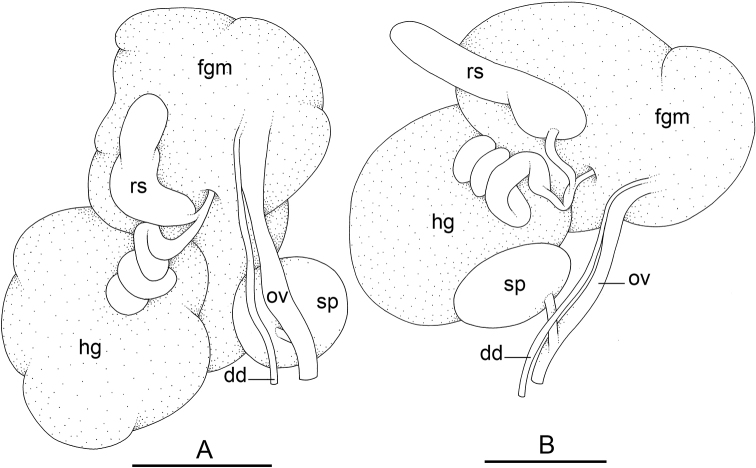
Posterior, hermaphroditic (female) reproductive system, Peronia
plateiA Papua New Guinea, Madang [5412] (MNHN-IM-2013-13351) B Hawaii, Oahu [6160] (BPBM 284527). Scale bars: 3 mm (A, B). Abbreviations: dd deferent duct, fgm female gland mass, hg hermaphroditic gland, ov oviduct, rs receptaculum seminis, sp spermatheca.